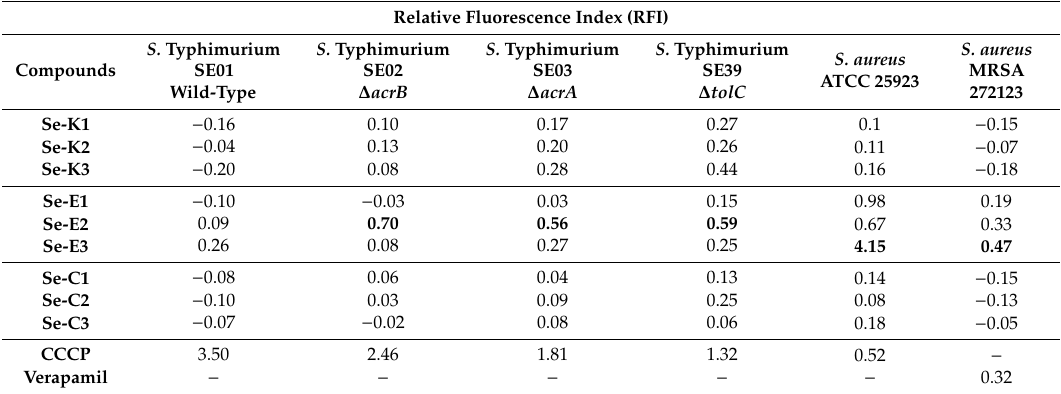
Table 3. Relative fluorescence indices based on real-time ethidium bromide (EB) accumulation data on S . Typhimurium and S. aureus strains. The active compounds are presented in bold. Relative Fluorescence Index